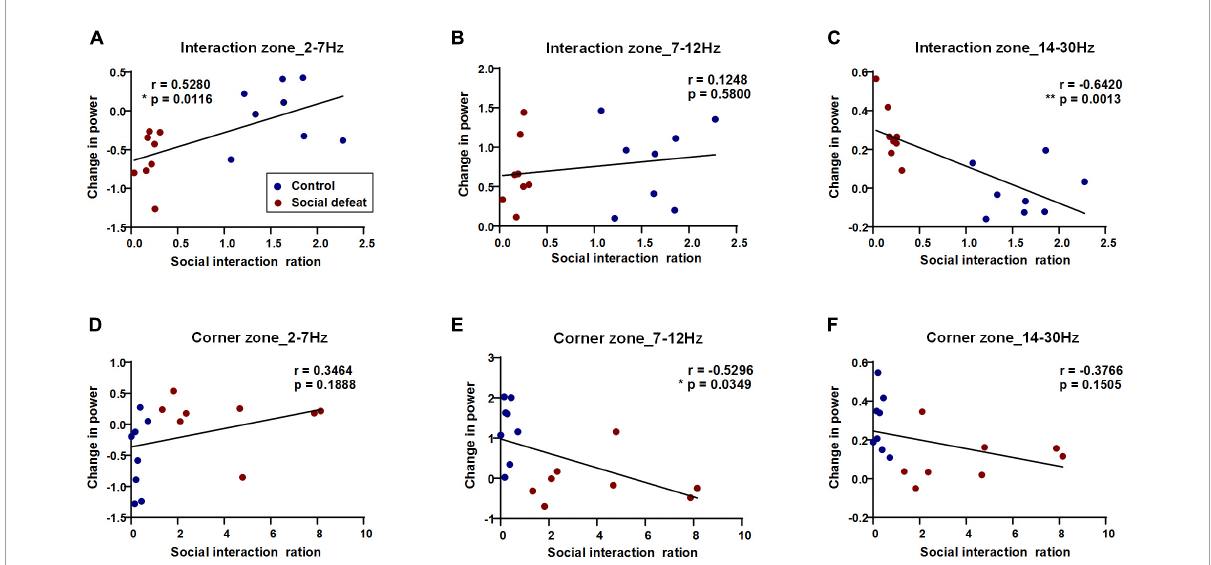
FIGURE5 PFC oscillatory activity in the social interaction test predicts the social interaction ratio. Pearson’s correlations and linear regression between power changes in different frequency ranges and behavioral states were shown (blue dots: control, n = 8 mice; red dots: social defeat, n = 8 mice). (A) Interaction zone, 2–7 Hz, correlation value: 0.5280, * p = 0.0116; (B) Interaction zone, 7–12 Hz, correlation value: 0.1248, p = 0.5800; (C) Interaction zone, 14–30 Hz, negative correlation value: – 0.6420, ** p = 0.0013; (D) Corner zone, 2–7 Hz, correlation value: 0.3464, p = 0.1888; (E) Corner zone, 7–12 Hz, negative correlation value: – 0.5296, * p = 0.0349; (F) Corner zone, 14–30 Hz, negative correlation value: – 0.3766, p = 0.1505.